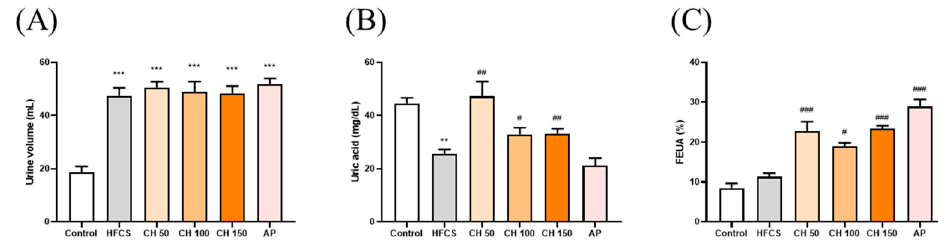
Figure 3. Effects of chrysin on ( A ) urine volume, ( B ) urine uric acid, and ( C ) fraction excretion of uric acid (FEUA). C: control; HFCS: high-fructose corn syrup group (10%